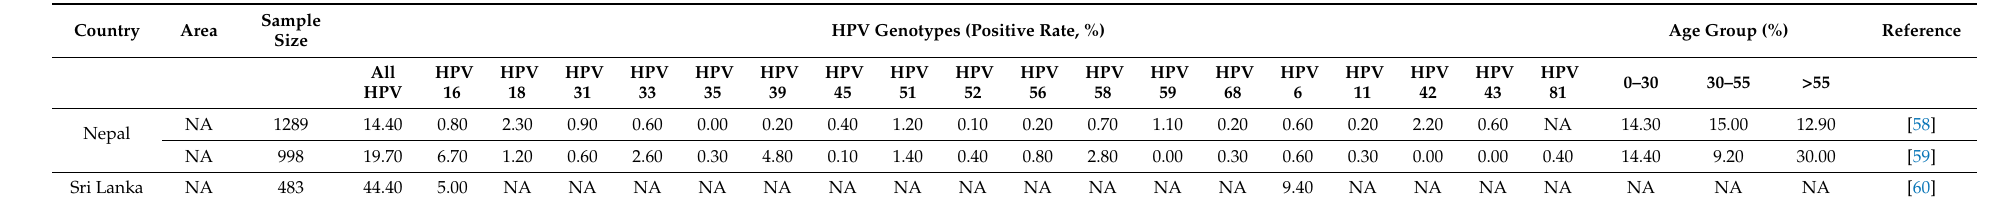
Table 5. The positive detection rate of HPV prevalence in cervical lesions by countries and age groups in South